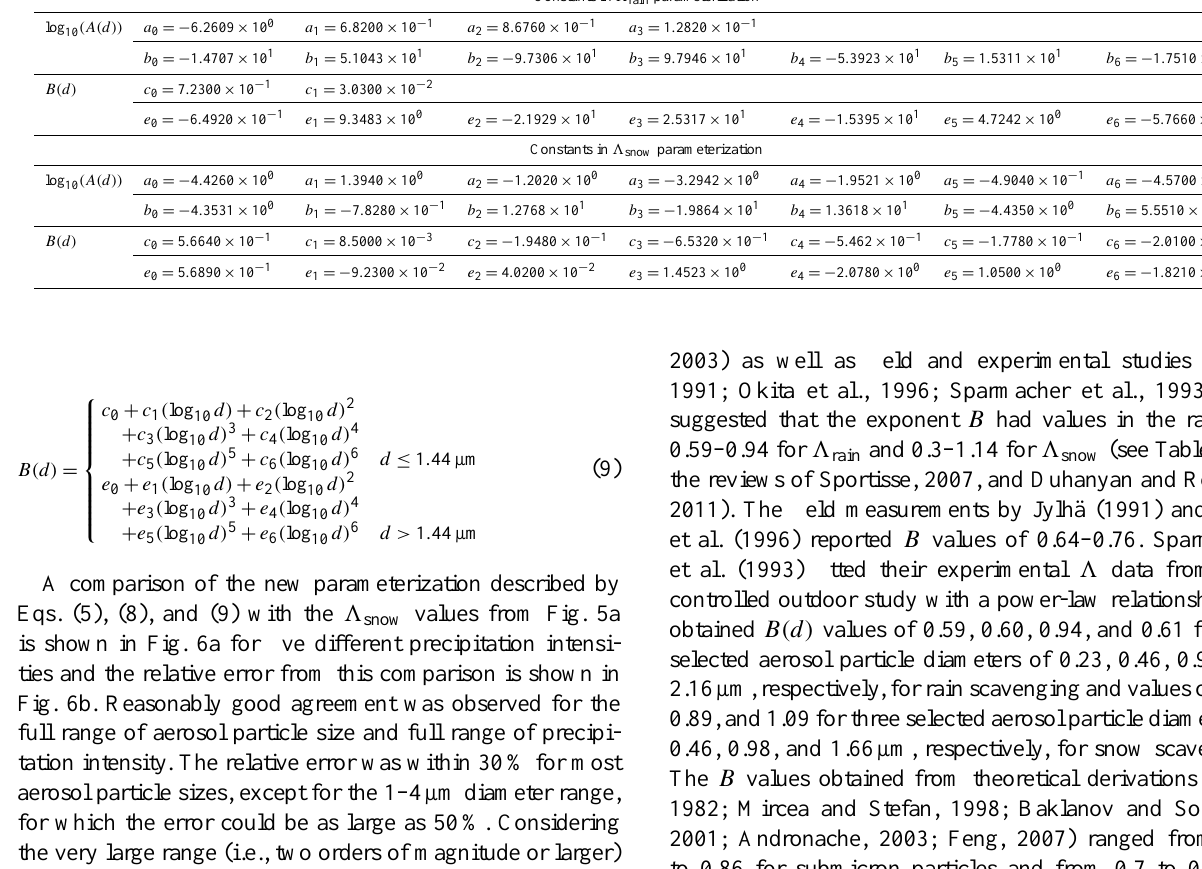
Table 8. Empirical constants in the formulations of log 10 (A(d)) and B(d) for 3 rain and 3 snow parameterizations. Constants in 3 rain